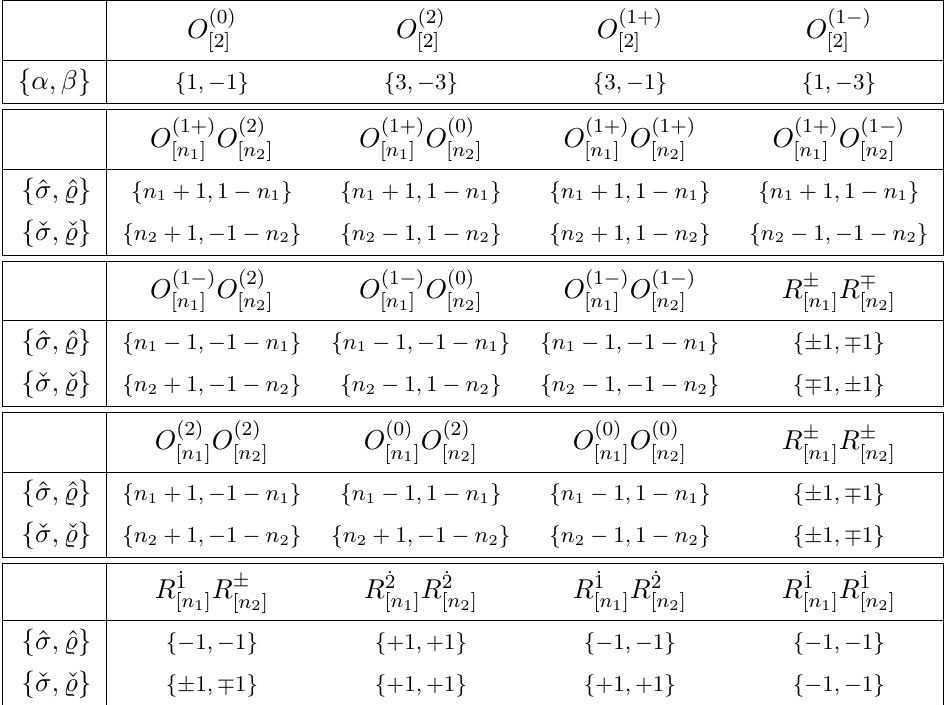
Table 1 . Parameters for making Z { α,β } mond